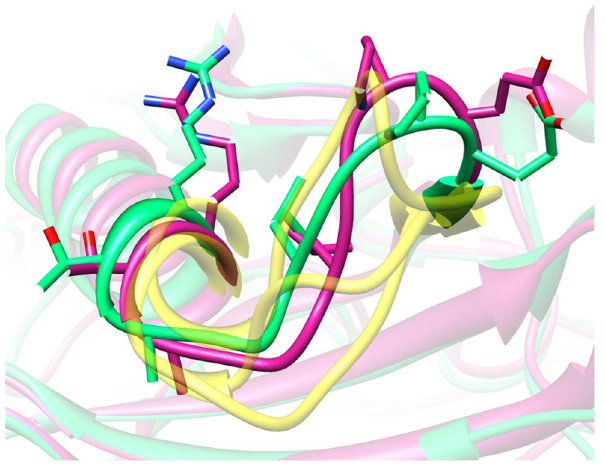
Figure 3. A successful example of loop modeling in the framework of a template-based model. The crystal structure is colored in green and the model in magenta (1avk, RMSD 5 1.5 A˚). Framework structures are shown transparent for clarity. Loops of three templates (used for template-based modeling) are shown with yellow transparent ribbons for